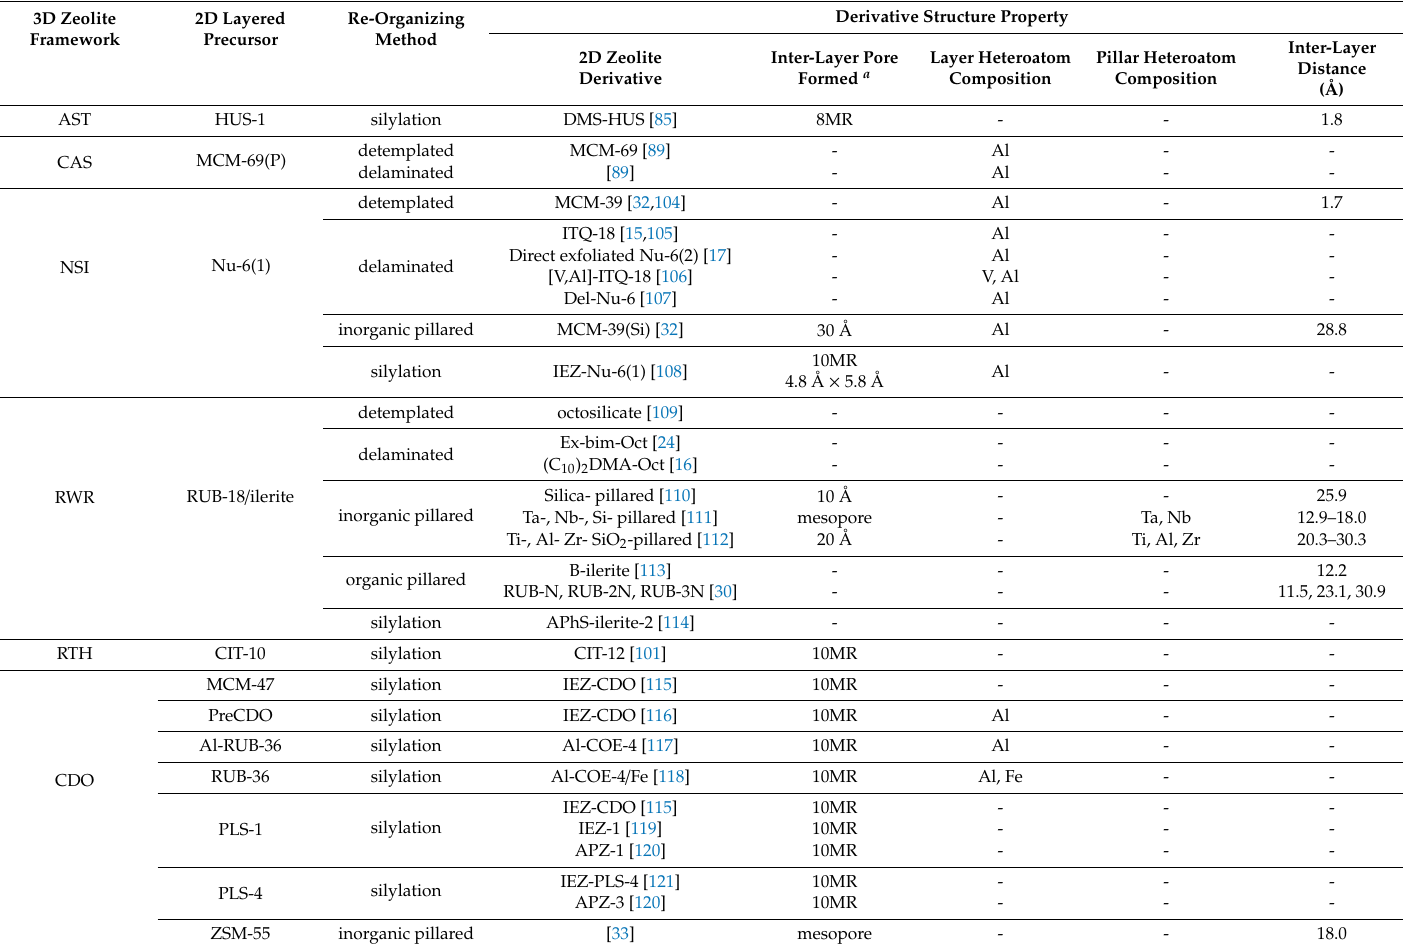
Table 3. Structural and compositional properties of 2D layered derivatives of AST (aluminophosphate with sequence number sixteen), CAS (cesium aluminosilicate), NSI ((Nu-6(2) (six)), CDO (CDS-1 (one)), RTH (RUB-13 (thirteen)) and RWR ((RUB-24 (twenty-four))